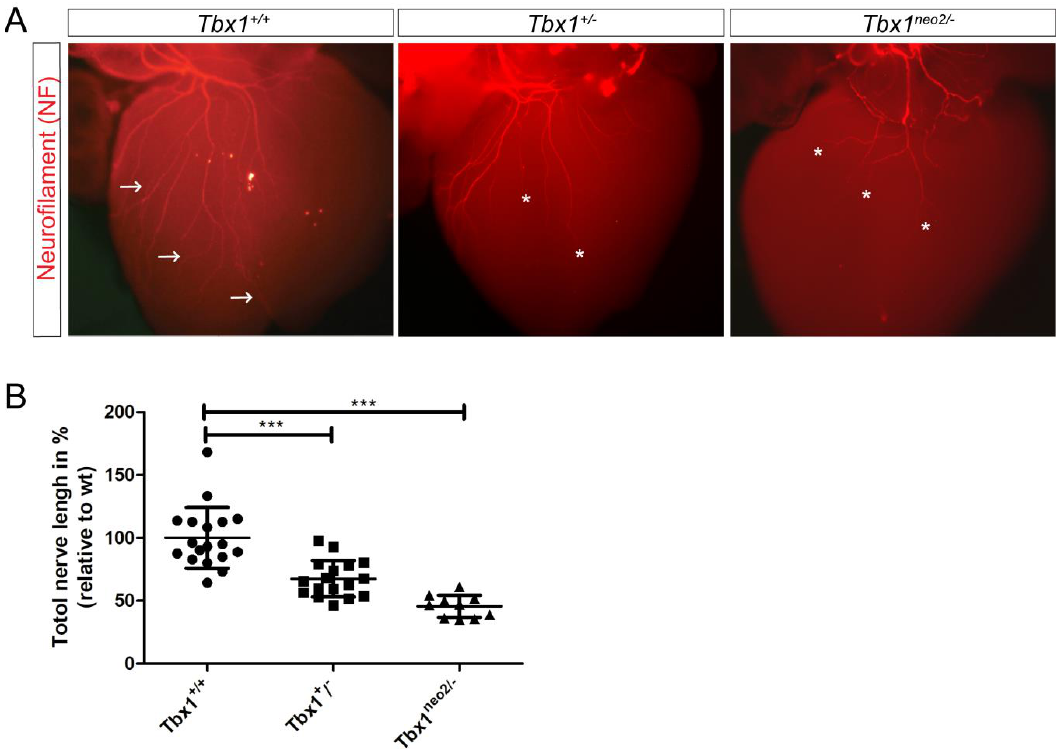
Figure 1. Tbx1 +/ − and Tbx1 neo2 / − have defective innervation. ( A ) Wholemount immunostaining at E15.0 for neurofilament-66 allowed visualisation of the parasympathetic innervation descending from the cardiac plexus and branching into the ventricles (white arrows). Truncation of axons was seen in Tbx1 +/ − and Tbx1 neo2 / − hearts (stars). ( B ) Quantification of axon branches on the dorsal surface of the heart in Tbx1 +/+ Tbx1 +/− and Tbx1 neo2 /− , *** p < 0.0001, F = 31.17 for three groups, df = 2. We observed fewer axonal branch points on the dorsal surface of the heart of E15 Tbx1 mutant embryos compared to wildtype littermates (Figure 1A, white asterisks). The total nerve branch length covering the dorsal ventricular surface area was measured and found to be significantly reduced from a control score of 100% in Tbx1 +/+ (6807 μm ± 1601 μm, n=18) to 61% in Tbx1 +/− (4150.3 μm ± 894.1 μm, n = 17) and to 49% (3399.1 μm ± 667.1 μm, n = 9) in Tbx1 neo2/− mutants (Figure 1B).